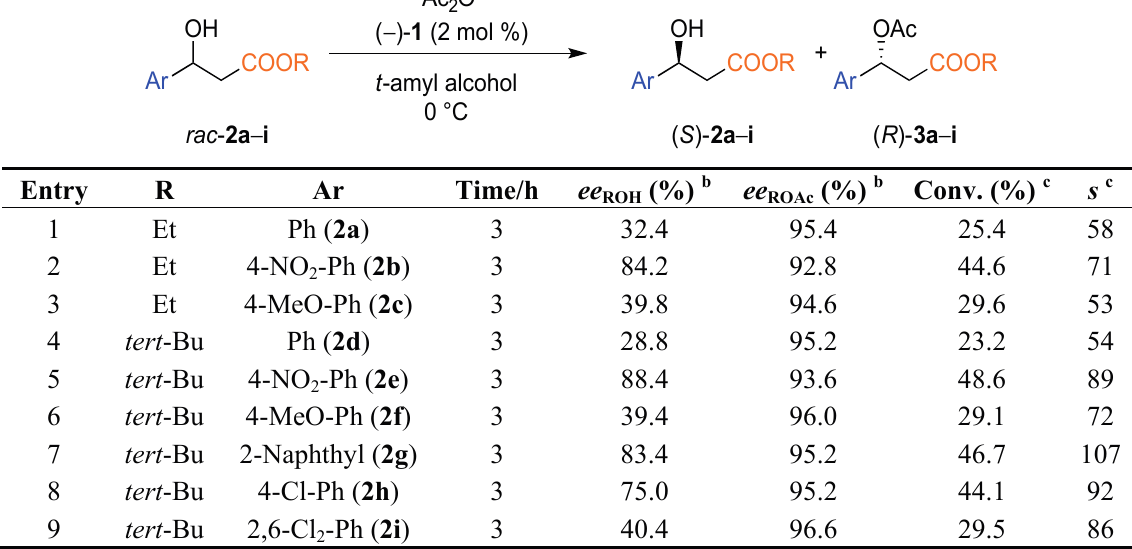
Table 1. Selectivity for the kinetic resolution of β -hydroxy - β -aryl esters ( rac -2) by ( − )-1 a